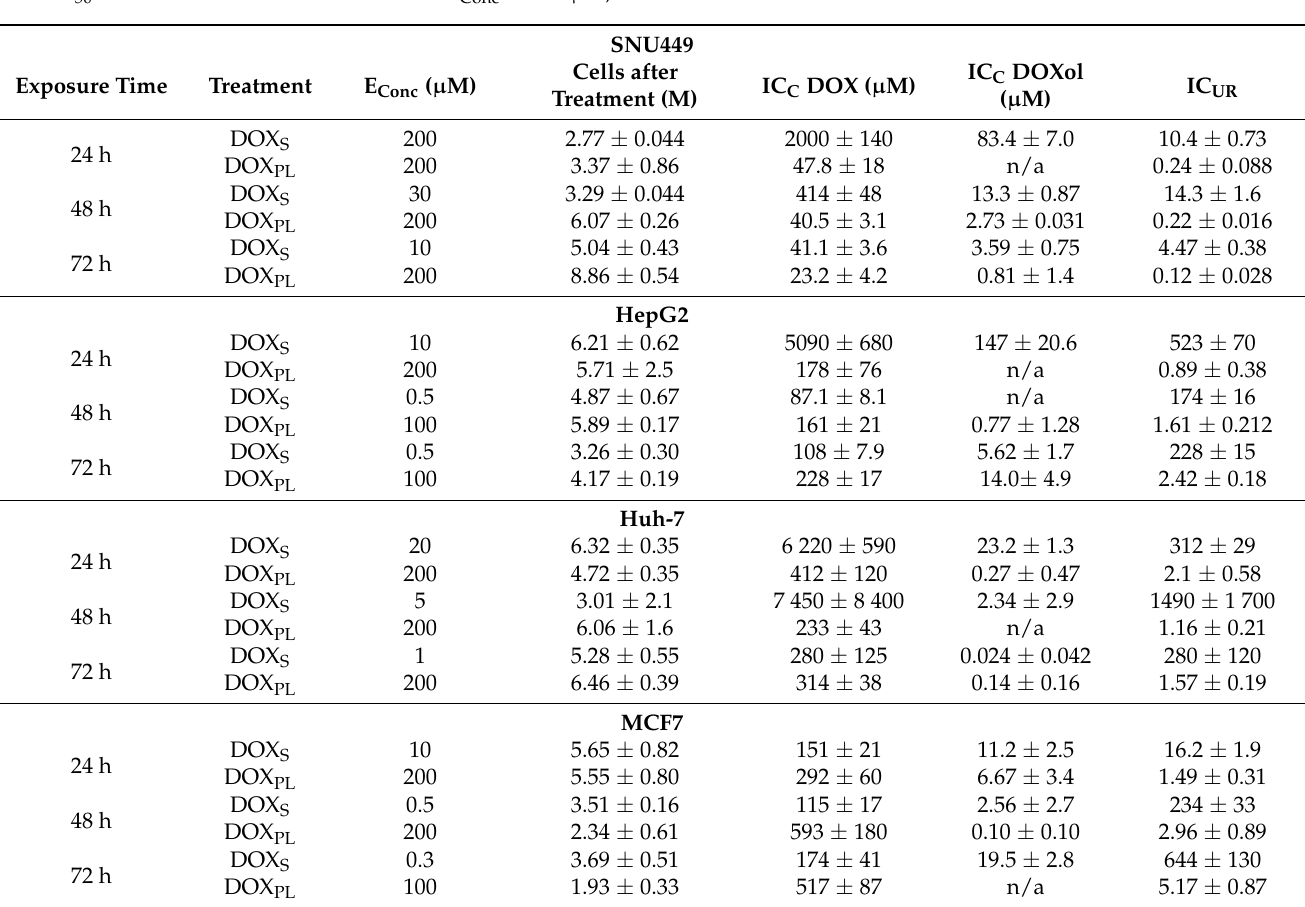
Table 3. The number of cells that were quantified, calculated mean ( ± SD) intracellular concentration (IC C ) of DOX and DOXol and intracellular uptake ratio (IC UR ) for DOX in the different cell lines at different exposure concentrations (E Conc ). When the quantified amount was below the LLOQ, it is symbolized with “n/a”. Each E Conc was based on the calculated IC 50 of that treatment with a maximum E Conc of 200 µ M, see Table 1 for more